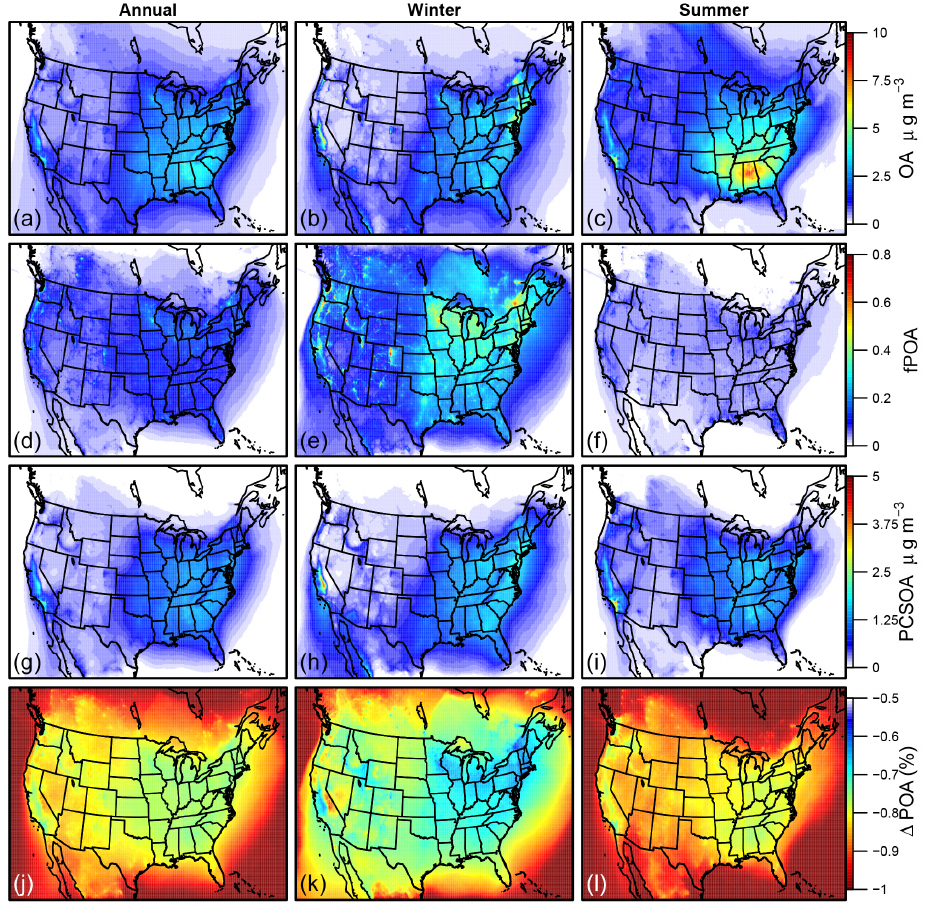
Figure 11. Spatial distribution of products form the LEBR CONUS11 simulation. Products include the OA concentration (row 1), fraction of POA (row 2), pcSOA concentration (row 3), and change in model-predicted POA from the nonvolatile POA model to the semivolatile POA model (row 4). Maps illustrate the median of all annual surface data (a, d, g, j) , winter months (December, January, February; b, e, h, k ), and summer months (June, July, August; c, f, i, l ).